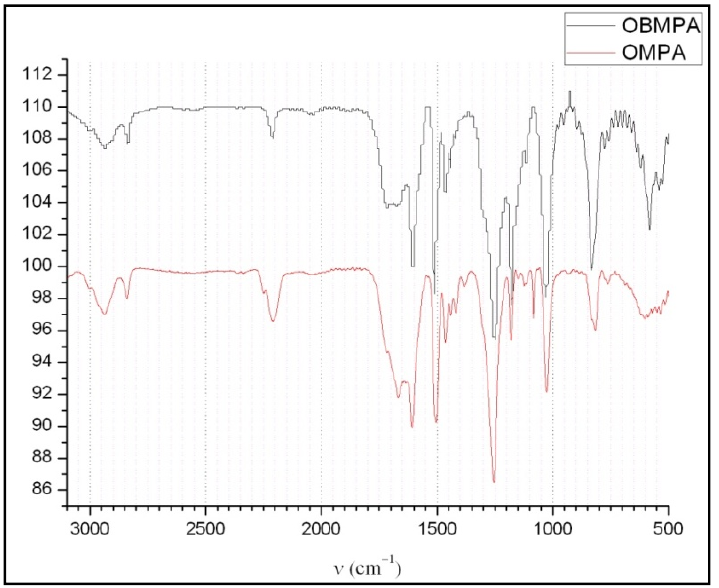
Figure 4. FTIR spectra of OBMPA ( top ) and OMPA ( bottom ).